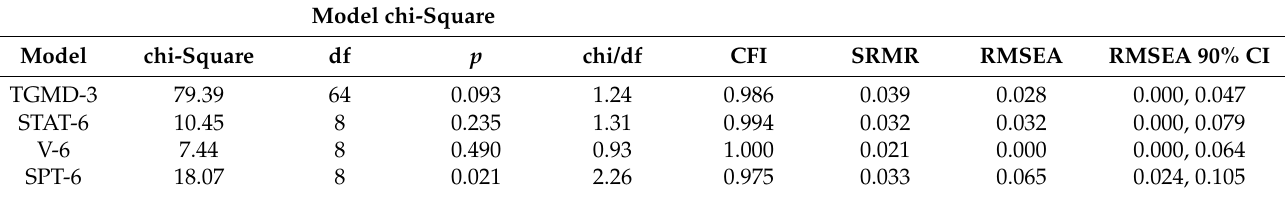
Table 3. Fit indices for the measurement model of various versions of the TGMD-3. Model chi-Square